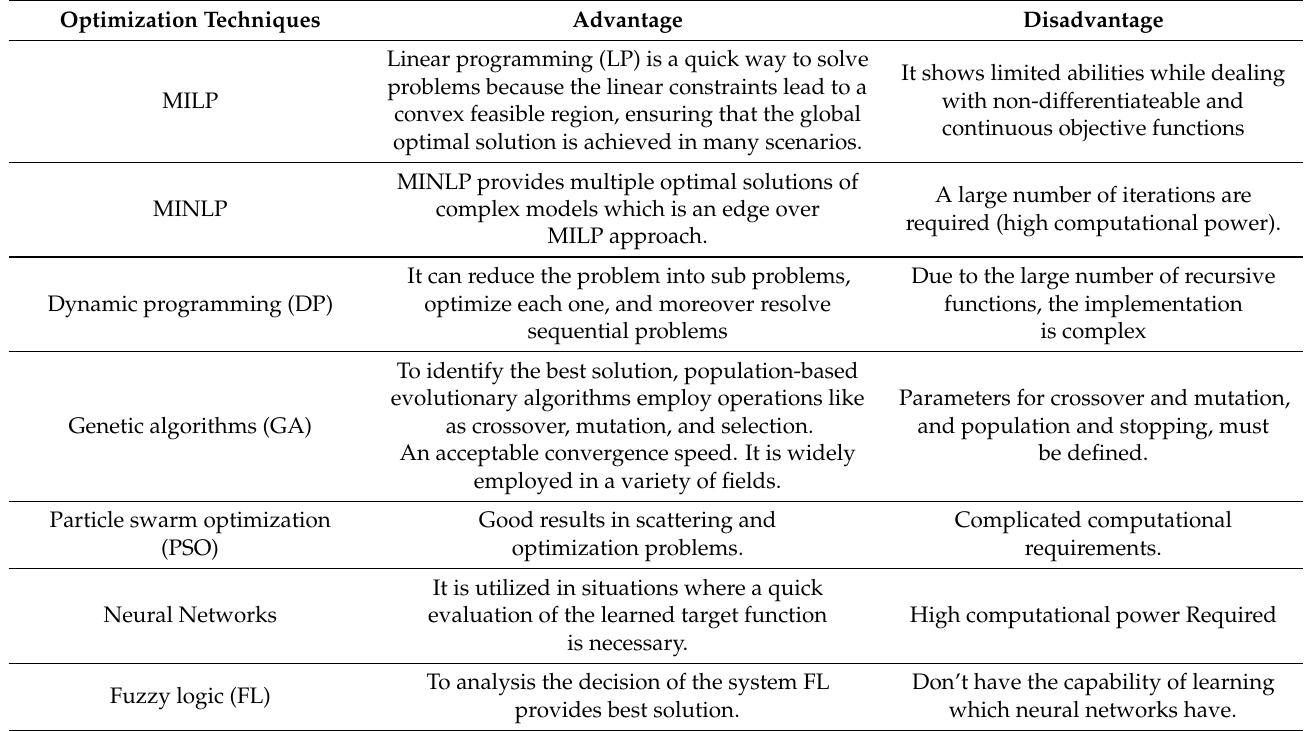
Figure 7. EMS optimization techniques. Table 4. Comparative analysis of optimization